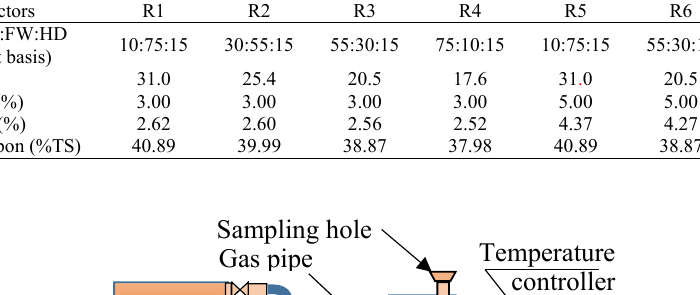
Table 2: The characteristics of the feedstock Reactors